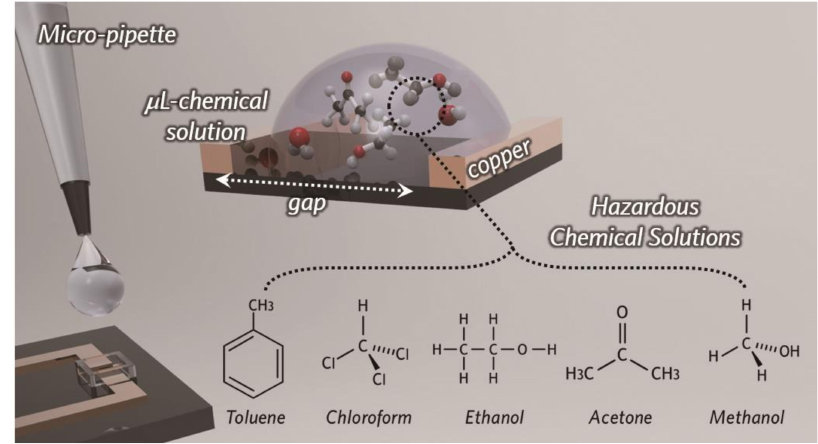
Figure 2. Schematic of sample preparation by drop casting and structures of sensing chemical materials.